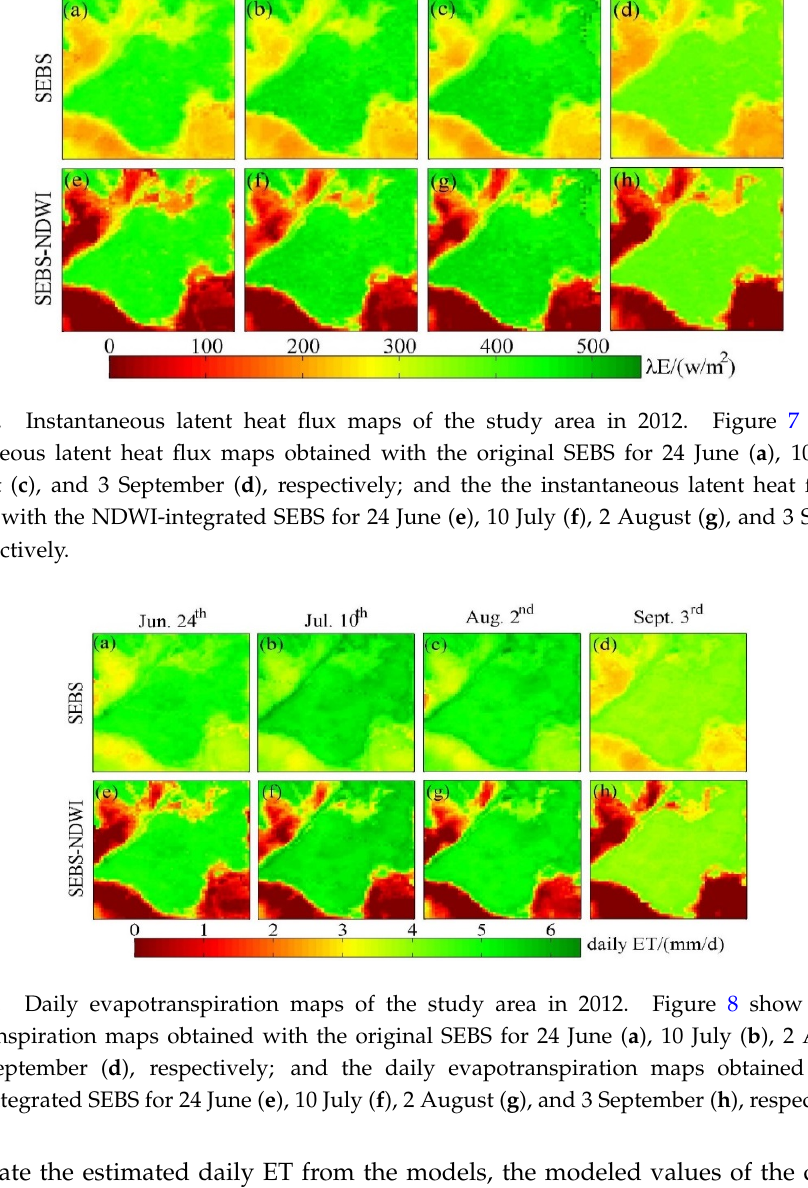
Figure 7. Instantaneous latent heat flux maps of the study area in 2012. Figure 7 show the instantaneous latent heat flux maps obtained with the original SEBS for 24 June ( a ), 10 July ( b ), 2 August ( c ), and 3 September ( d ), respectively; and the the instantaneous latent heat flux maps obtained with the NDWI-integrated SEBS for 24 June ( e ), 10 July ( f ), 2 August ( g ), and 3 September ( h ), respectively.